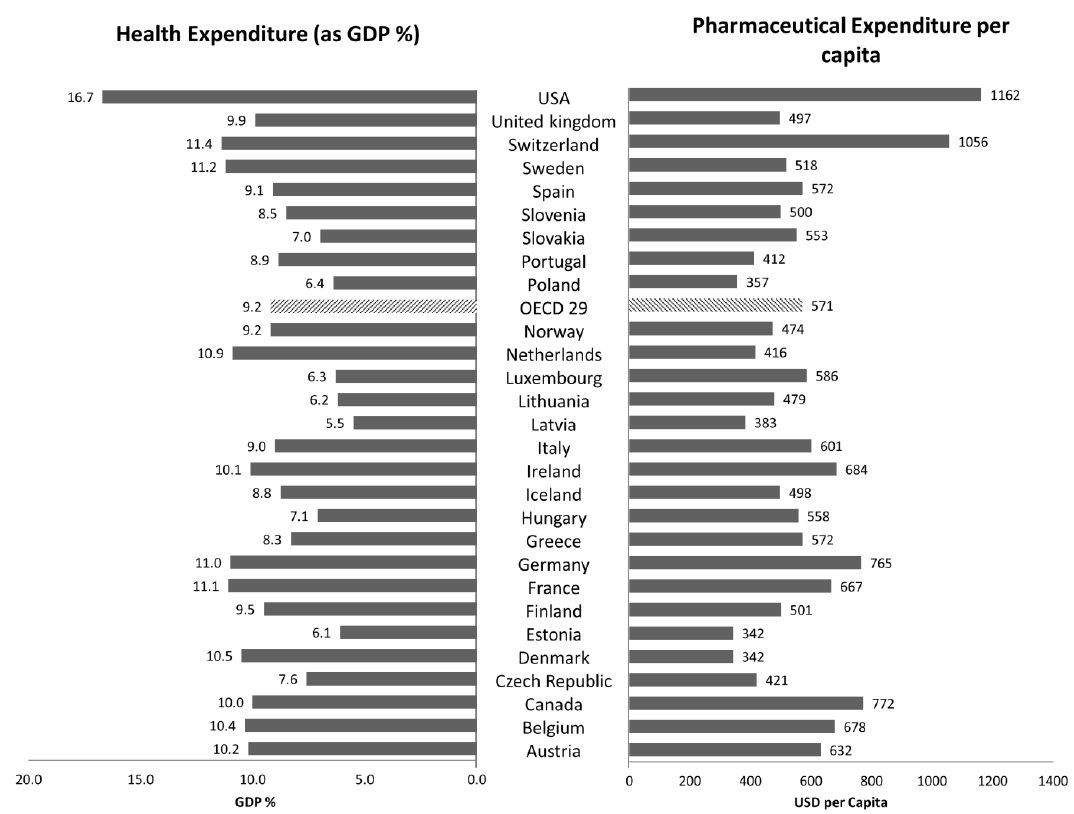
Figure 1. Health Expenditure as % of GDP and Pharmaceutical Expenditure per capita (in USD) of 29 OECD countries in 2015 [2]. From the median of the examined period till the onset of the COVID-19 pandemic (2019), for OECD countries the average of health expenditure as % of GDP decreased from 9.2% to 8.7%, whereas for the US the same parameter was constant in both years at 16.7% [2].